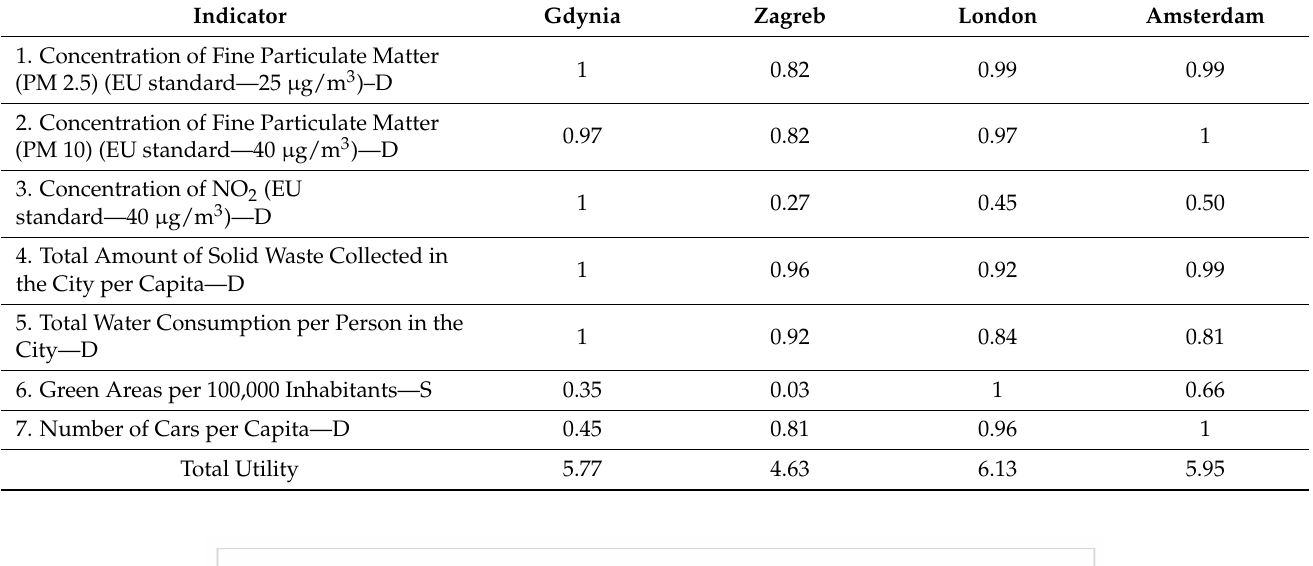
Table 4. Partial and total utility for the environmental dimension indicators. Indicator